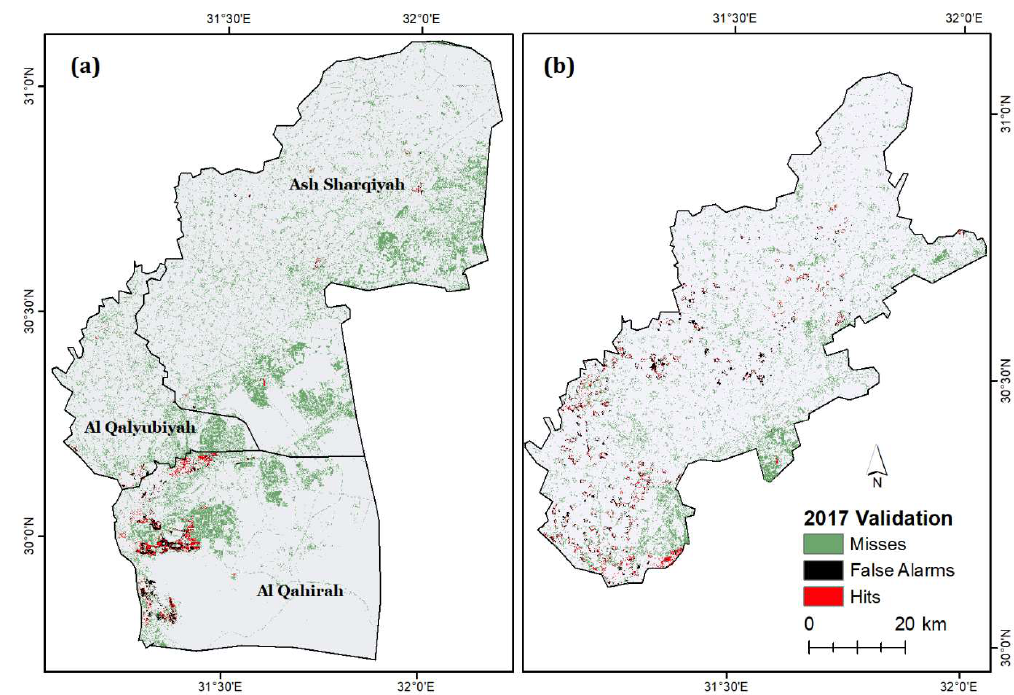
Figure 3. Validation map of the 2017 simulation ( a ) for the ND flank including desert, and ( b ) for the cultivated lands flank of the ND. The final output determines the overall accuracy of the model and confirms its use for further simulations.